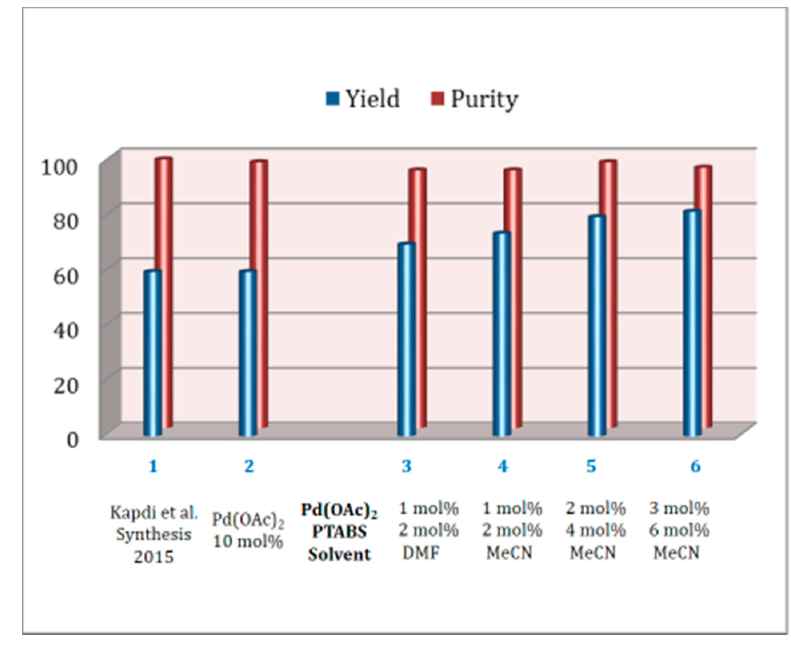
Figure 7. Improvement in the synthesis of Ruth